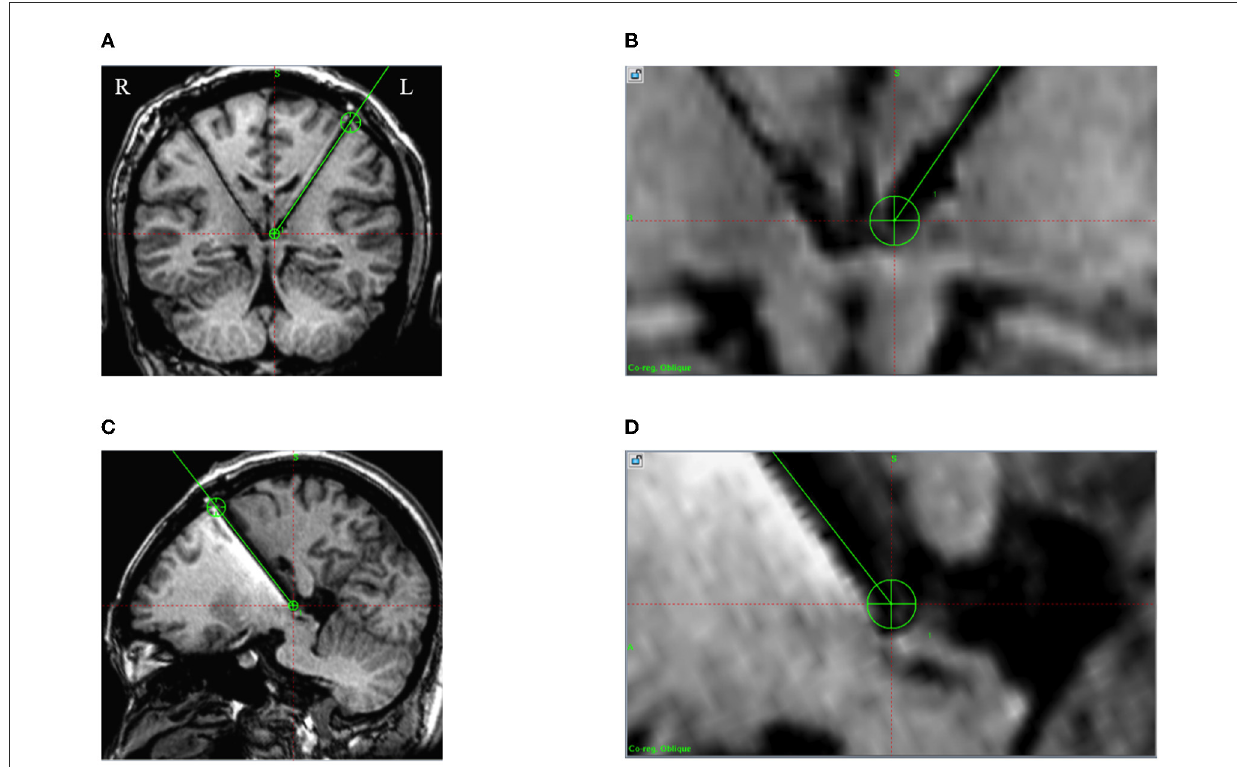
FIGURE3 Intraoperative 3D T1 images in case 5. A green line is the preoperative planning trajectory, and the dark signal shows the positions of the electrode and lead. (A, B) The actual implanted DBS electrode consistent with the preoperative plan on the coronal plane; (C, D) The actual implanted DBS electrode consistent with the preoperative plan on the sagittal plane.